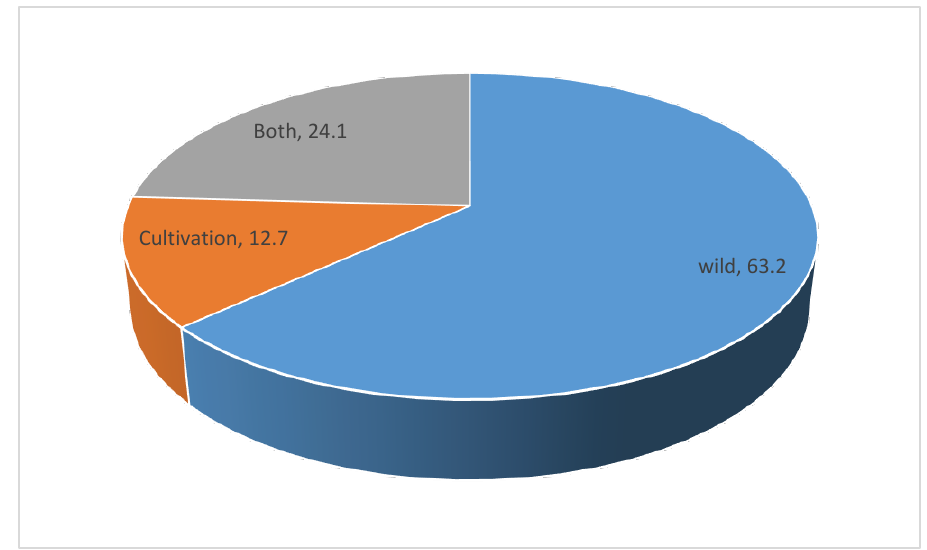
Figure 6. Distribution (%) of the sources of the 87 plant species used against cough associated with respiratory diseases in Ede South Local Government Area of Osun state, Nigeria.